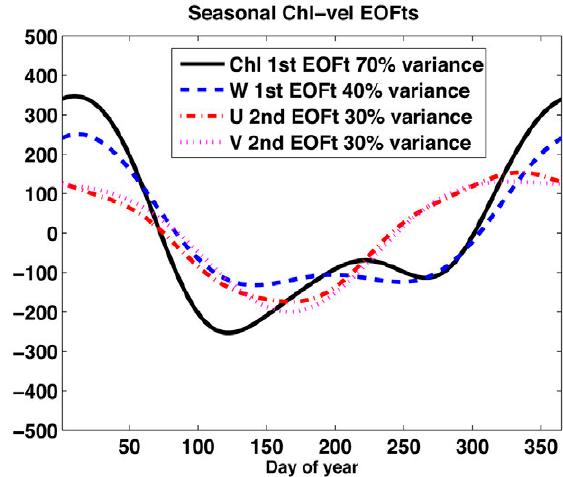
Fig. 4. – Seasonal EOFts of ocean components (without time lag): first EOFt of Chl a and W, second EOFt of U and